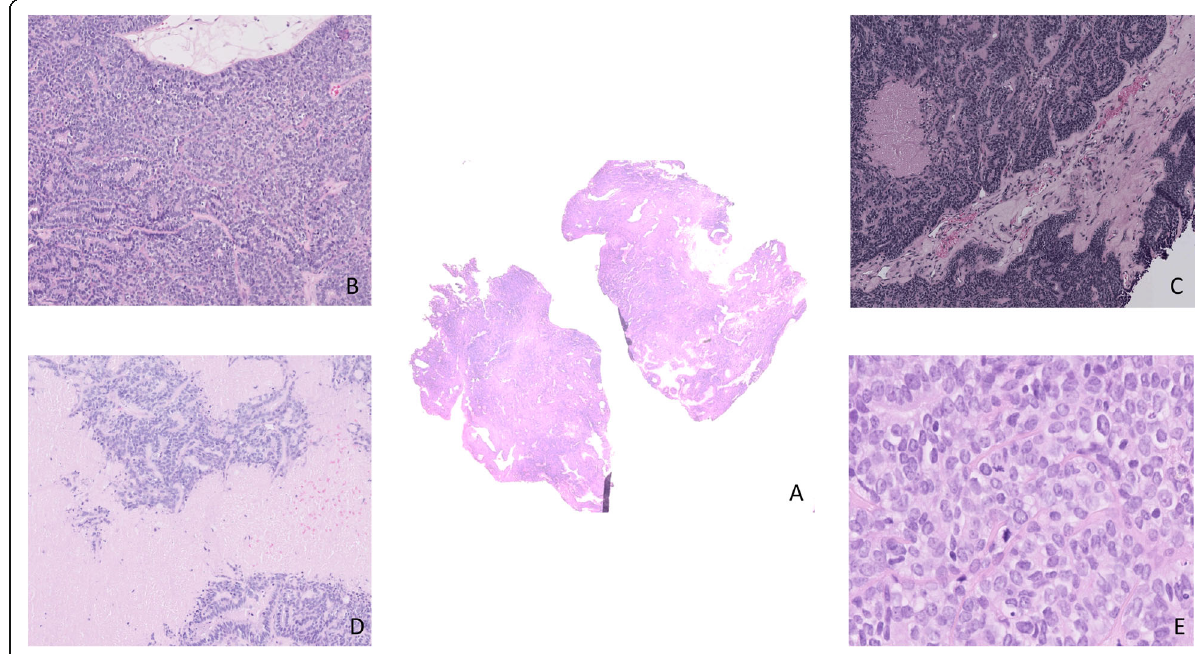
Fig. 1 a . Tumor aspect at low power × 20. b . Tumor arranged in solid aggregates and cords of basaloid tumor cells × 40. c . Fibrous and vascularized tumoral stroma with a slight lymphocytic infiltrate × 100. d . necrosis dissectinf the tumor × 40. e . Basaloïd tumor cells with mild